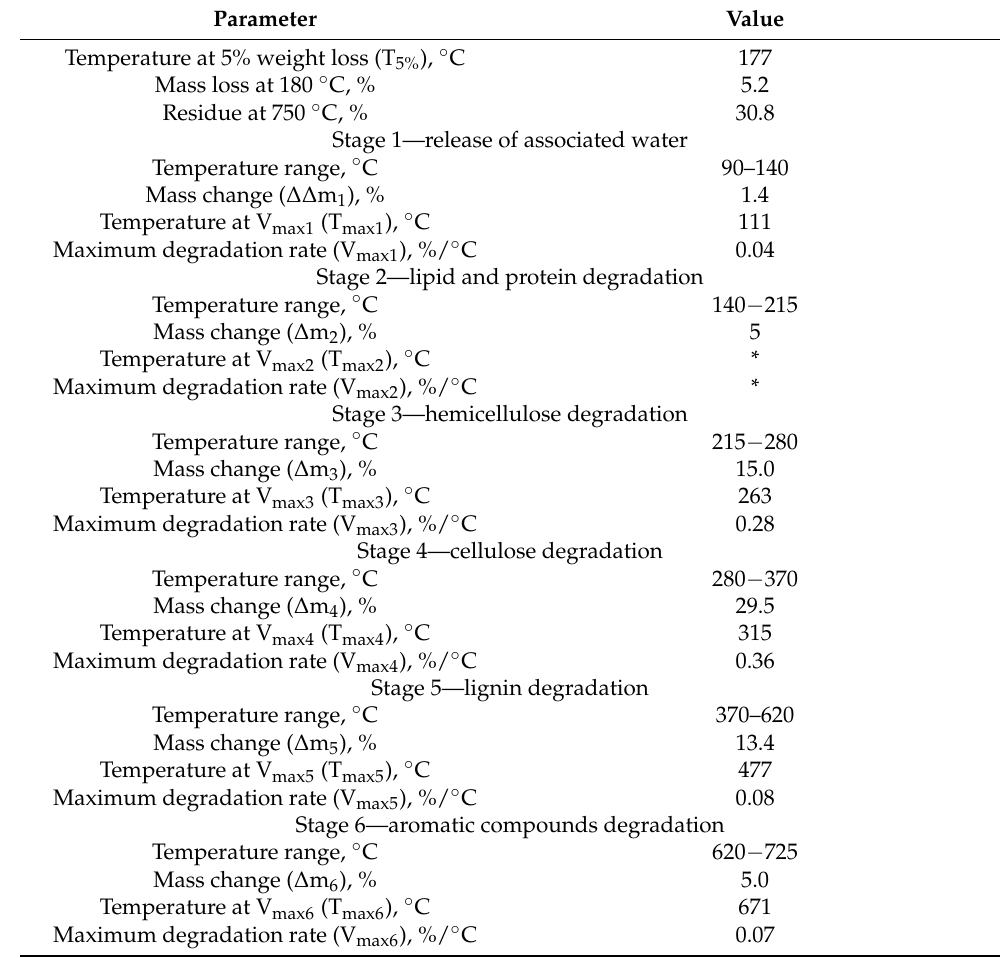
Table 3. Results of TG and DTG analysis of hop